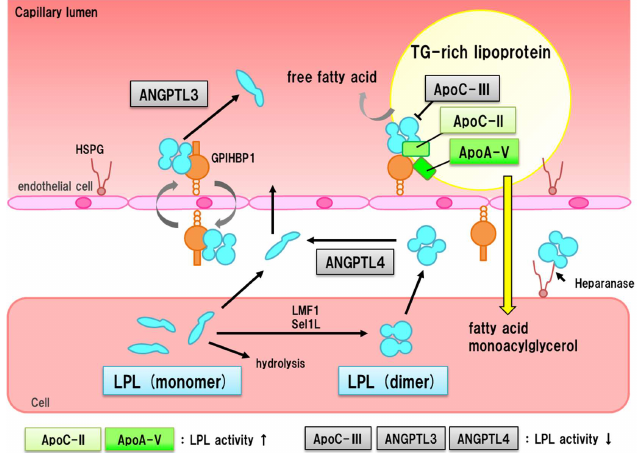
Figure 4. LPL pathway and associated proteins.